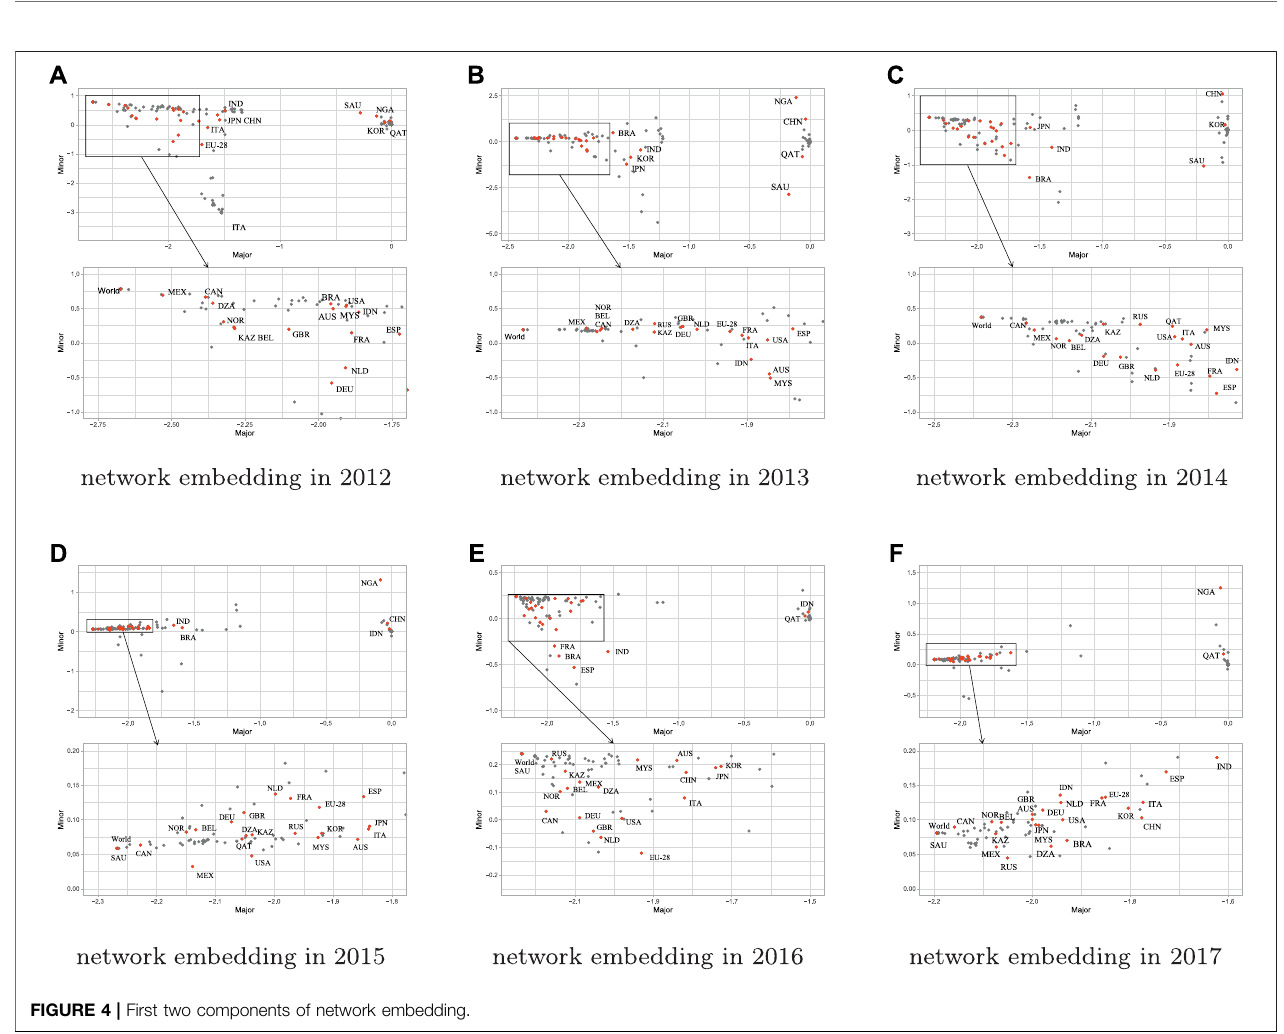
FIGURE 4 | First two components of network